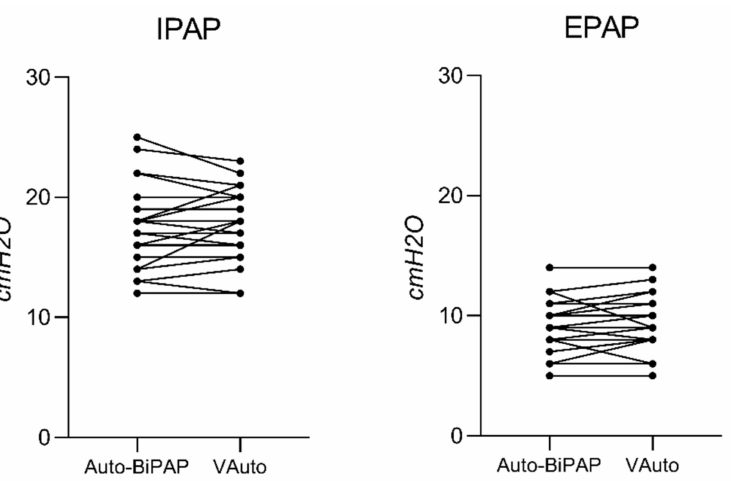
Figure 3. Setting of the therapeutic pressures (IPAP and EPAP) of two auto-adjusting bilevel devices (Auto-BiPAP vs. VAuto) compared in the